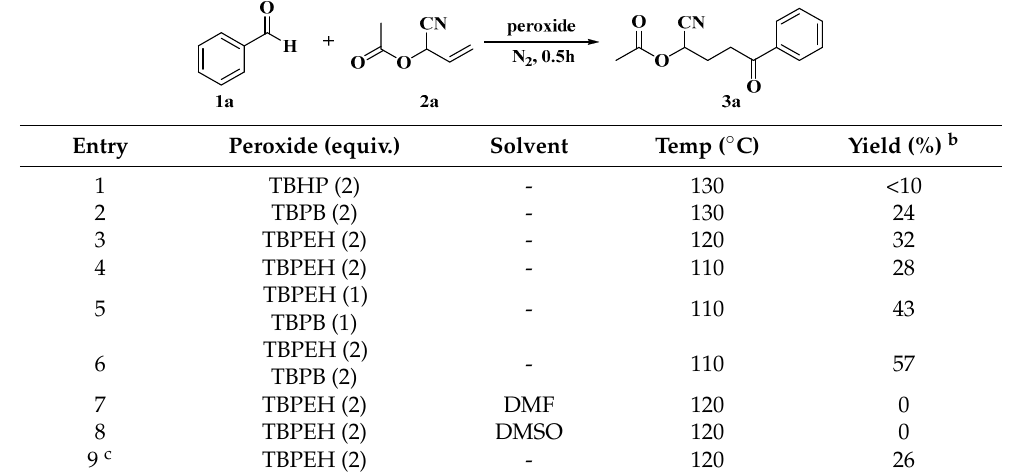
Table 1. Effects of reaction conditions on the yields of compound 3a a .